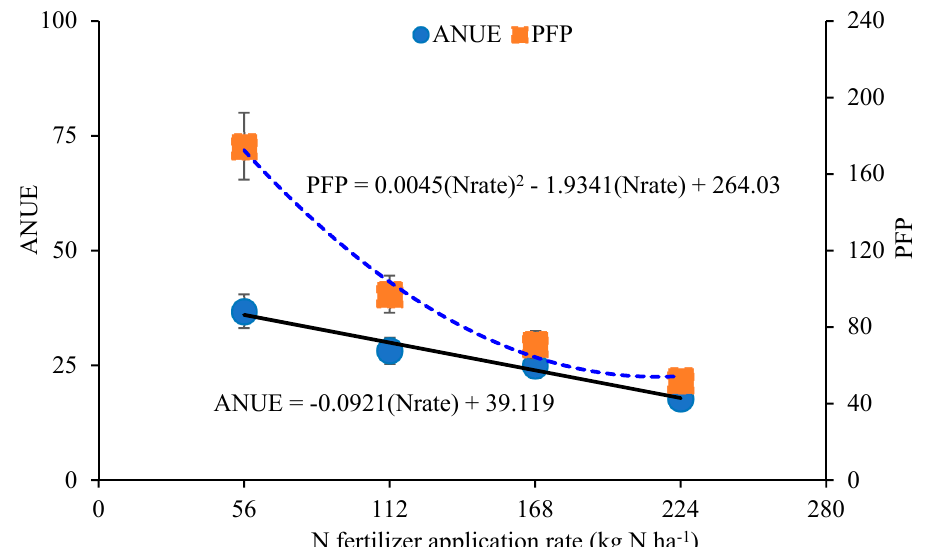
Figure 2. Agronomic N use efficiency (ANUE) and partial factor productivity (PFP) response to nitrogen (N) fertilizer application rate when data combined over years (2019 and 2020) and N fertilizer application time at Swan Lake Research Farm, near Morris, MN. Error bars are standard error of the means.